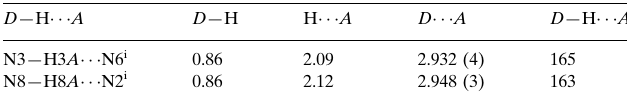
Hydrogen-bond geometry (A˚ , (cid:1)